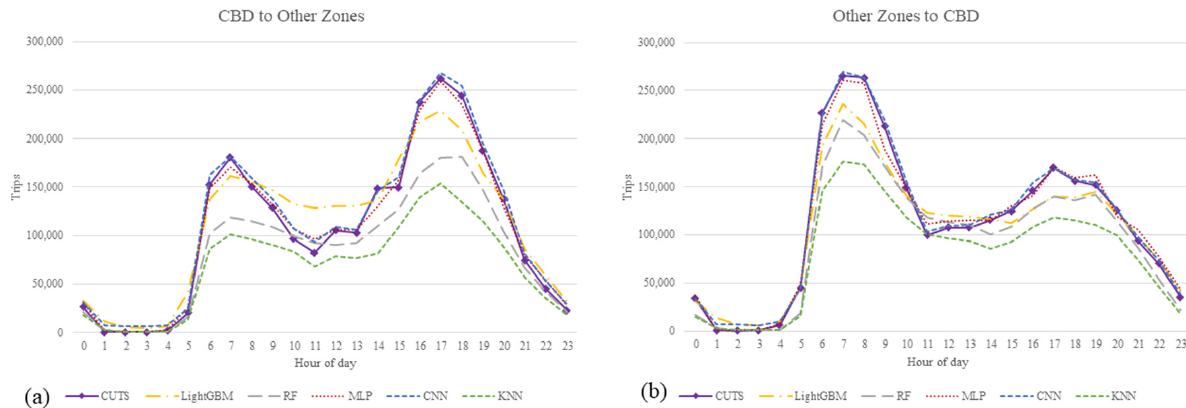
Figure 10. Comparison between developed models according to hourly distribution for CBD of Tehran. ( a ) temporal dis-